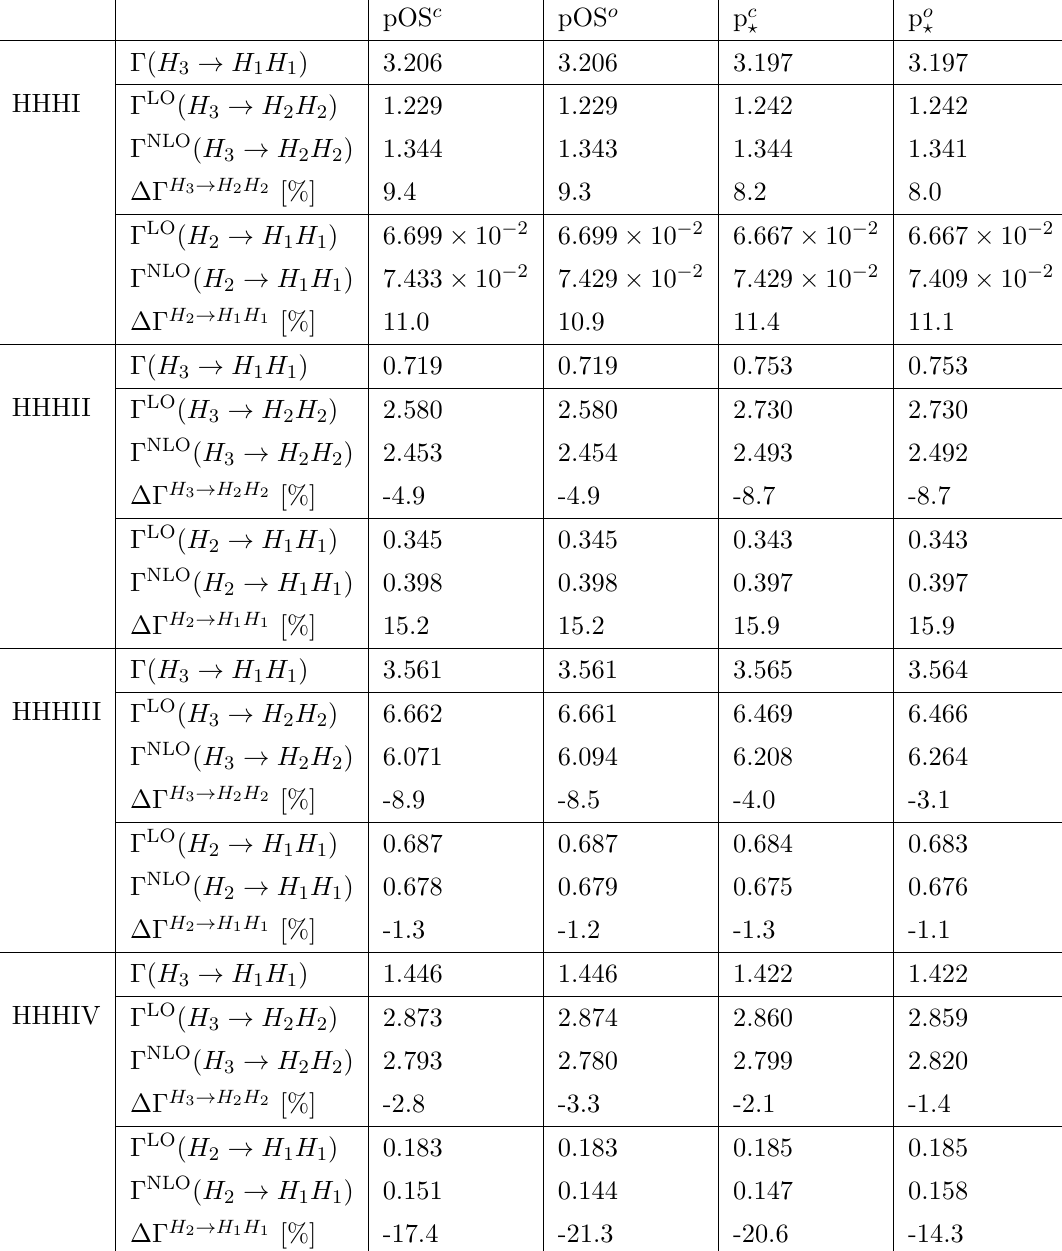
Table 11 . Higgs decay width predictions (in GeV) at LO and NLO EW accuracy as well as the relative corrections for the N2HDM benchmarks presented in table 10 and four di(cid:11)erent renormal- ization